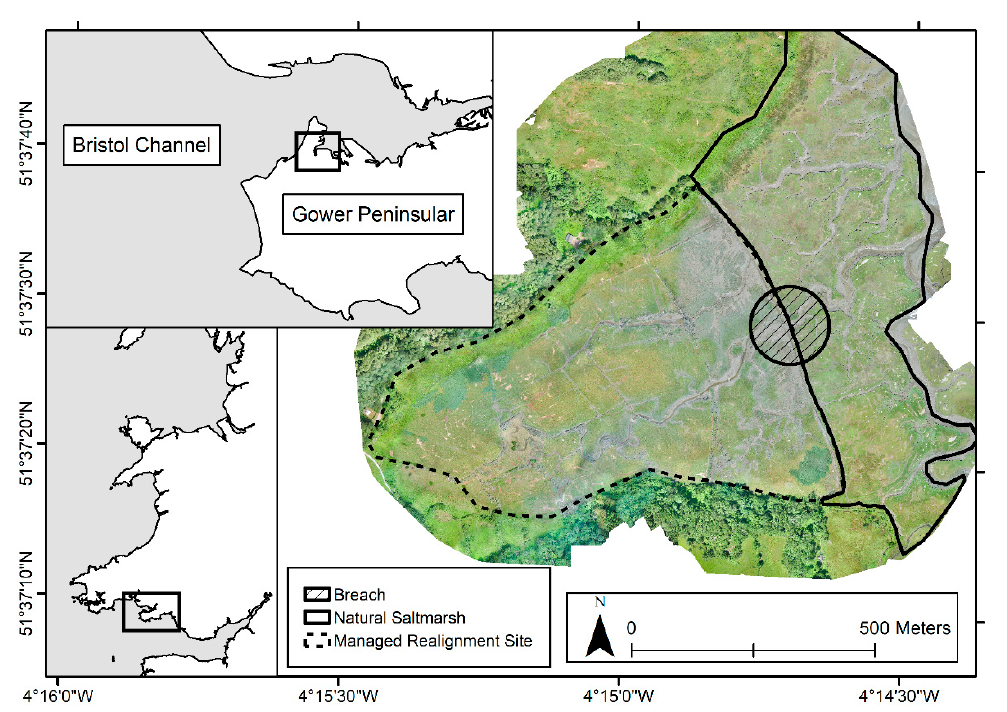
Figure 1. Orthophotography of the site from the unmanned aerial vehicle survey, and the regional and national setting (both inserts). The site outline is marked by the dashed black line, the external natural saltmarsh considered in this study indicated by the solid black line, and the creek drainage systems visible. The former sea wall is located at the boundary between the natural marsh and the managed realignment site, with the breach area identified.